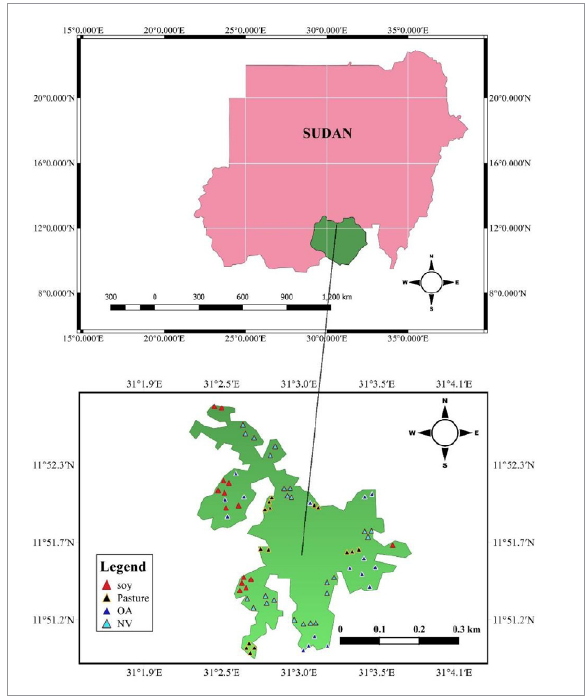
Figure 1: Map of the study area showing distribution of sampling sites.